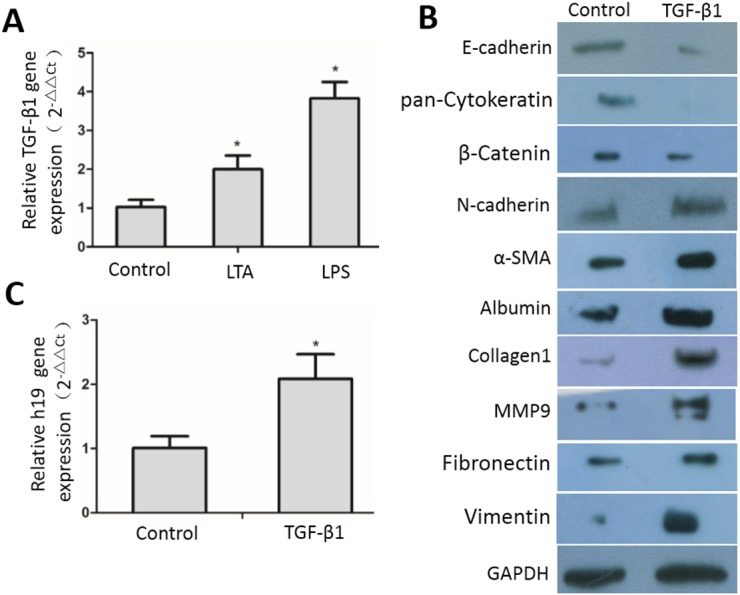
TGF-β1-induced expression of EMT markers, ECM proteins and H19 in MAC-T cells.(A) Expression of TGF-β1 gene in inflammatory MAC-T cells was analyzed by RT-qPCR. (B) Expression of EMT markers (E-cadherin, N-cadherin, pan-cytokeratins, vimentin, β-catenin and α-SMA), ECM protein (albumin, MMP9, collagen type I and fibronectin ) in MAC-T cells were analyzed by western blotting. (C) Expression of H19 in MAC-T cells upon TGF-β1 treatments was analyzed by RT-qPCR. Untreated MAC-T cells were used as a control. GAPDH was used as an internal control. ∗p < 0.01 vs control.